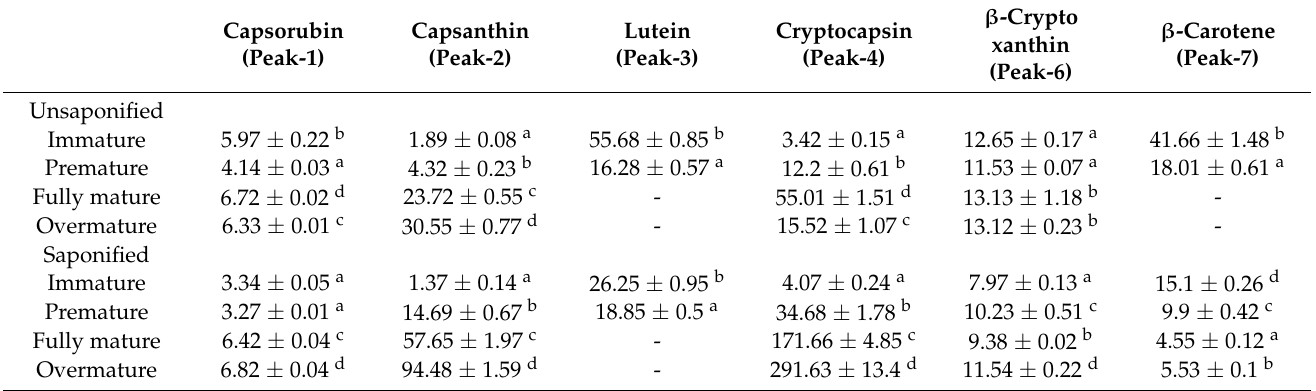
Figure 6. Comparison of HPLC profiles of un-saponified ( A ) and saponified ( B ) extracts of MT fruits at different maturity stages: a, immature (pale green); b, premature (brownish); c, fully mature (red); d, overmature (deep red); 1, capsorubin; 2, capsanthin, 3, lutein; 4, cryptocapsin; 5, unidentified; 6, β -cryptoxanthin; 7, β -carotene; 8, cryptocapsin esters; 9. capsanthin esters. Table 2. Comparison of main carotenoids content at different maturity stages of MT